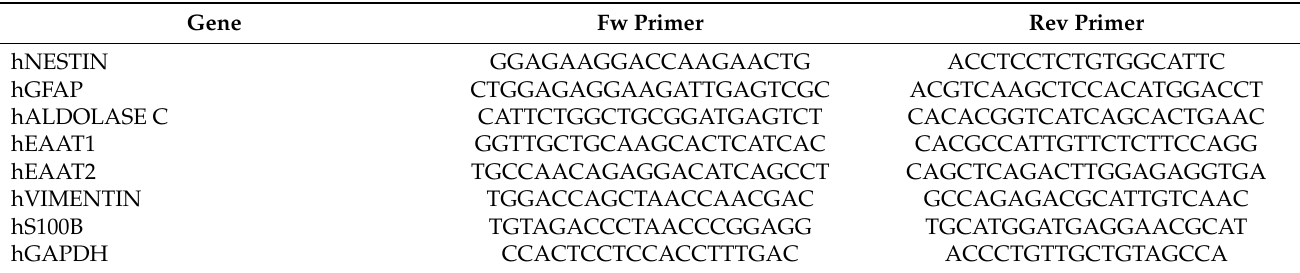
Table 1. Sequences of the primers employed in this